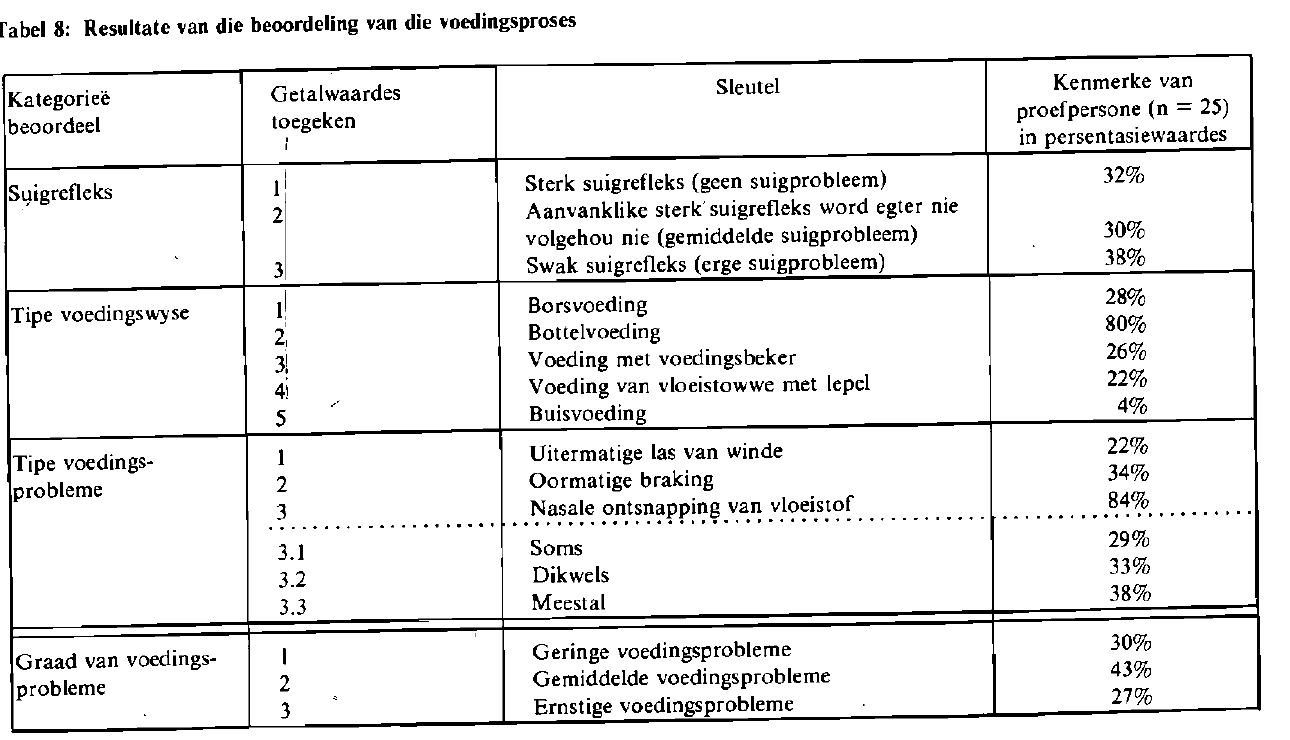
Dit blyk dus op grond van die verkree resultate dat die vlak van ontwikkeling in grade van normaliteit en agterstand uitgelig kan word wat onder andere toegeskryf word aan die feit dat die proef- persone se relatiewe ontwikkelingsouderdom gebruik is. Dit laat toe vir 'n meer gedetailleerde interpretasie van funksionering. Relatiewe ontwikkelingsouderdom verwys na die ouderdomsvlak wat op die evaluasieskaal behaal is, minus die baba se chronolo- giese ouderdom. Dit wil se, die vlak van funksionering relatief tot die individu self word bepaal (Fox et al. 1978). Die evaluering van funksionering deur middel van die toepassing van ontwikkelingskale blyk dus 'n efiektiewe evaluasiemetode te wees en talle riglyne vir behandeling word verskaf.